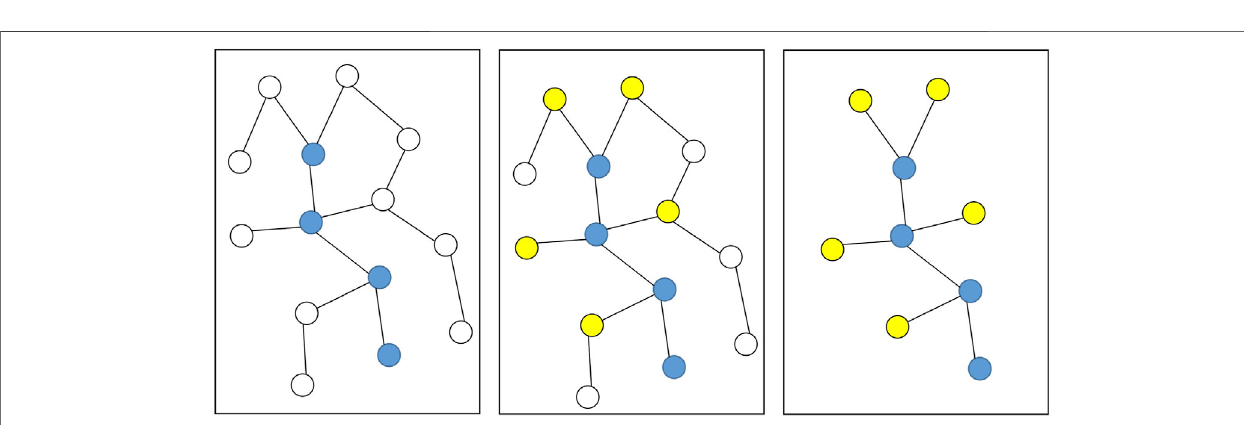
Frontiers in Physics |